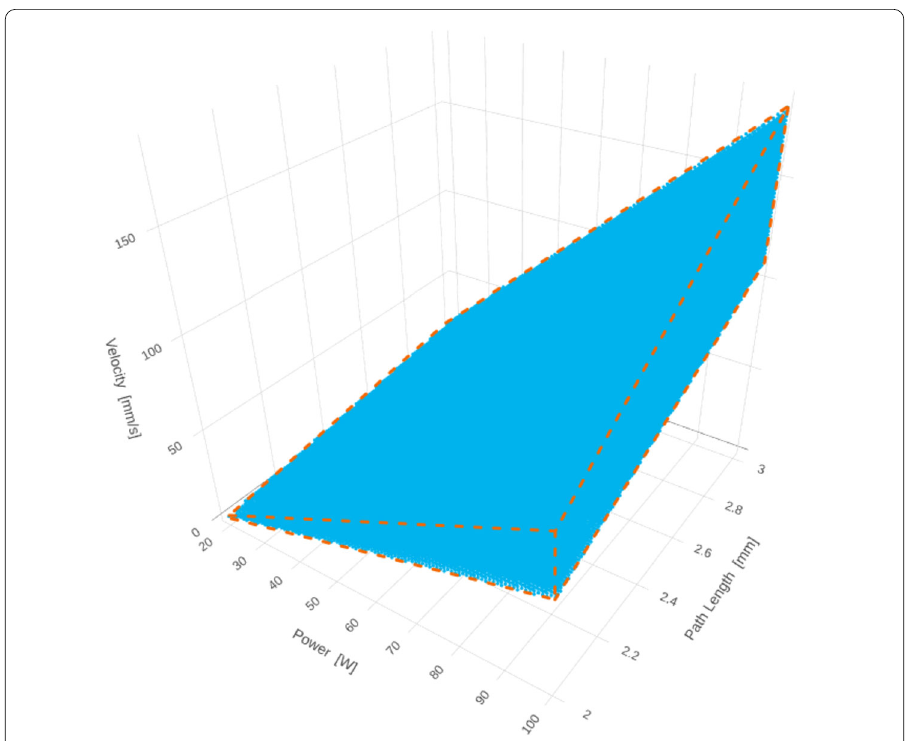
Figure 8 Optimization inputs feasible